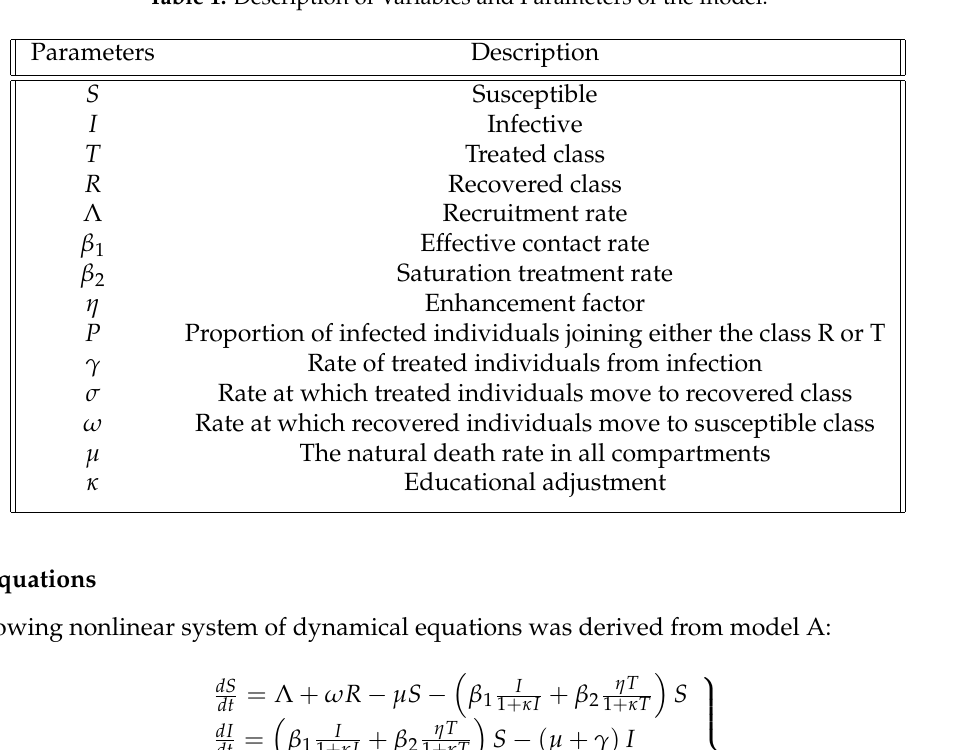
Table 1. Description of Variables and Parameters of the